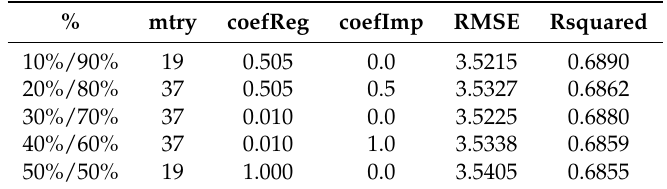
Table 5. Summary of Leave-One-Out-Cross-Validation test using Regularized Random Forest (RRF) method. %